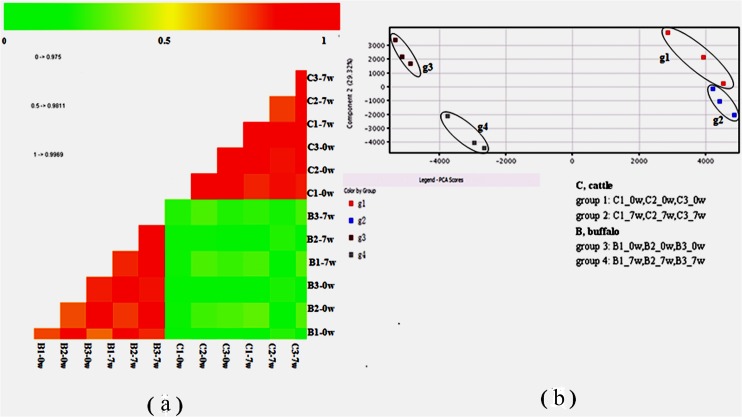
Global microarray data analysis.(a) Correlation analysis for all samples; (b) Principal component analysis (PCA) of the transcript profiles from g1, g2, g3 and g4. g1 and g2 represent the samples from pre-infection and post-infection, respectively, in yellow cattle (C, cattle);g3 and g4 represent the samples from pre-infection and post-infection, respectively, in water buffalo (B, buffalo).